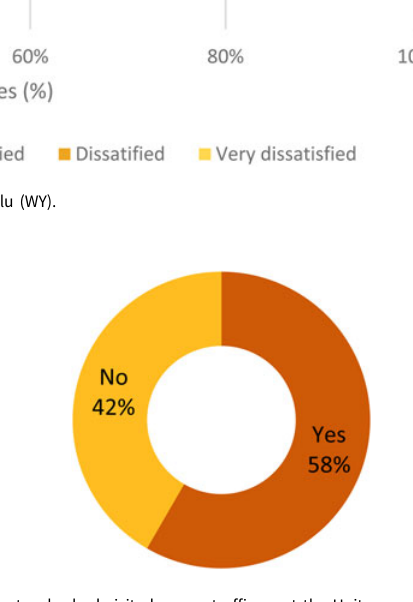
Fig. 4. Students who had visited support officers at the